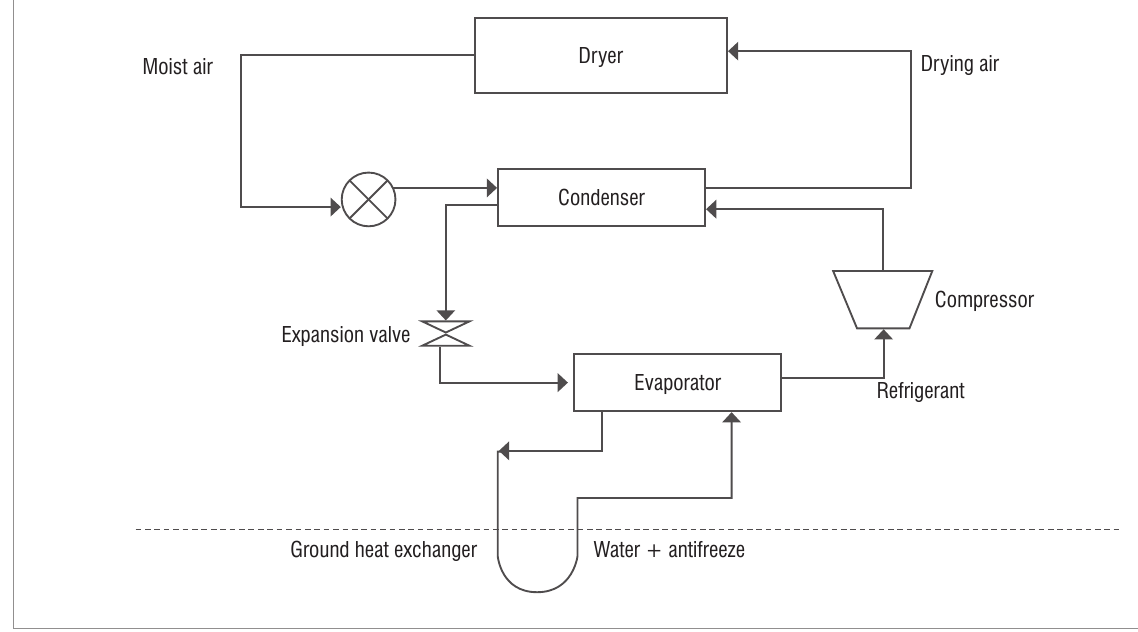
Figure 5: Schematic diagram of a ground source heat pump dryer. 47